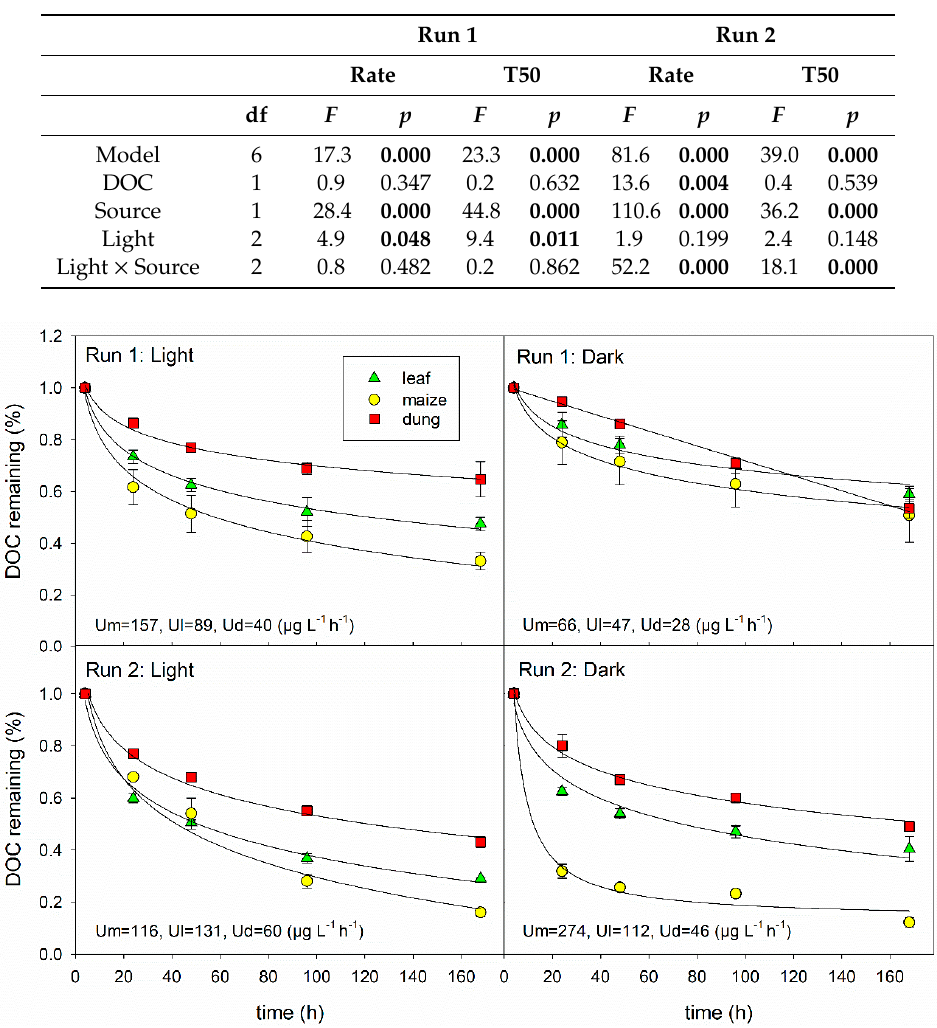
Figure 2. Dissolved organic carbon (DOC) uptake curves for leaf, maize, and dung leachates in light and dark flumes during run 1 and run 2 (DOC as relative proportion remaining). Shown are DOC concentrations in the water column per time (means and standard deviations, n = 3), fitted uptake curves, and initial uptake rates (U) during the first 20 h for maize (Um), leaf (Ul), and dung leachates (Ud). In both runs, DOC uptake rates were positively correlated with DOC ( p < 0.001) and SRP ( p < 0.04) concentrations and negatively with NH 4 -N ( p < 0.05) concentrations of the leachates (Pearson, n =